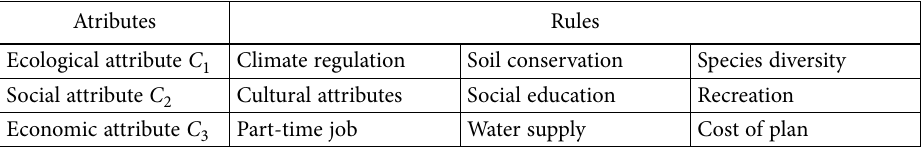
Table 1. The rules of different attributes Atributes Rules